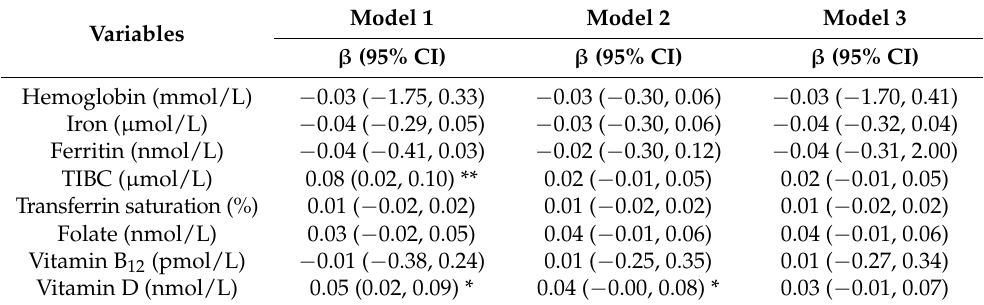
Table 5. The association of dairy and nondairy alternatives dietary pattern with anemia-related biochemical variables in serum evaluated by the generalized linear regression analysis 1 .